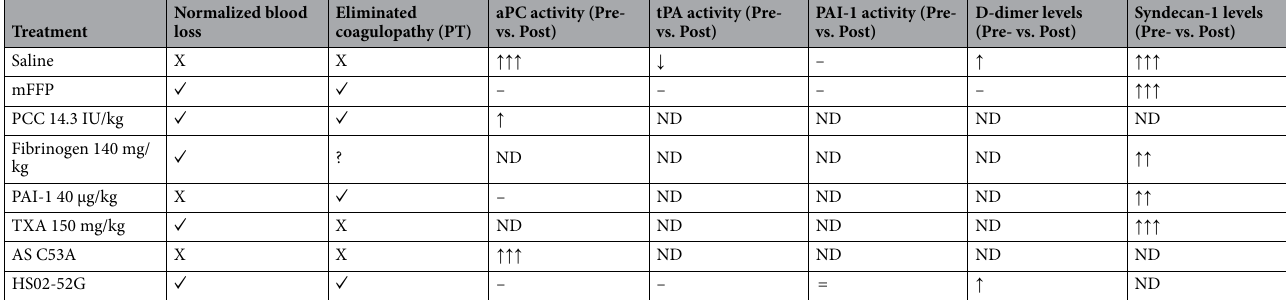
Table 1. Summary of findings. For principal outcomes (blood loss and coagulopathy) “ ✓ ” signifies positive finding and “X” signifies negative finding; “?” signifies indeterminate finding, with high variance and possible interference from pre-existing aggregates in some samples. For additional outcomes (aPC, tPA, PAI-1, D-dimer, and syndecan-1), ↑↑↑ indicates major increase, ↑↑ indicates intermediate increase, ↑ indicates increase, ↓ indicates decrease, – indicates no change, and ND indicates not determined, all Post-HS/LL values relative to